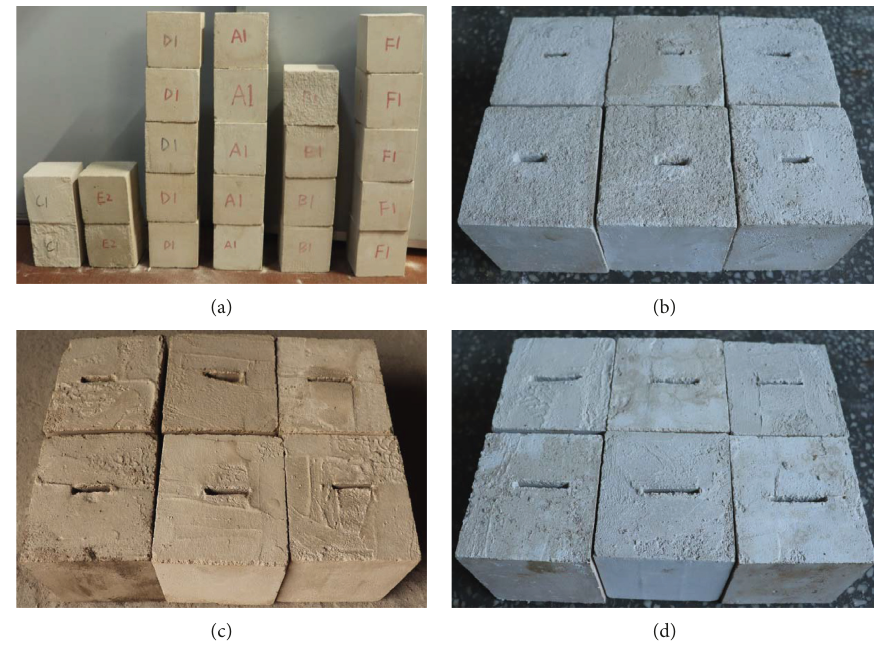
Figure 2: Joint specimens with different persistency. (a) Intact specimens, (b) λ � 30%, (c) λ � 30%, and (d) λ �